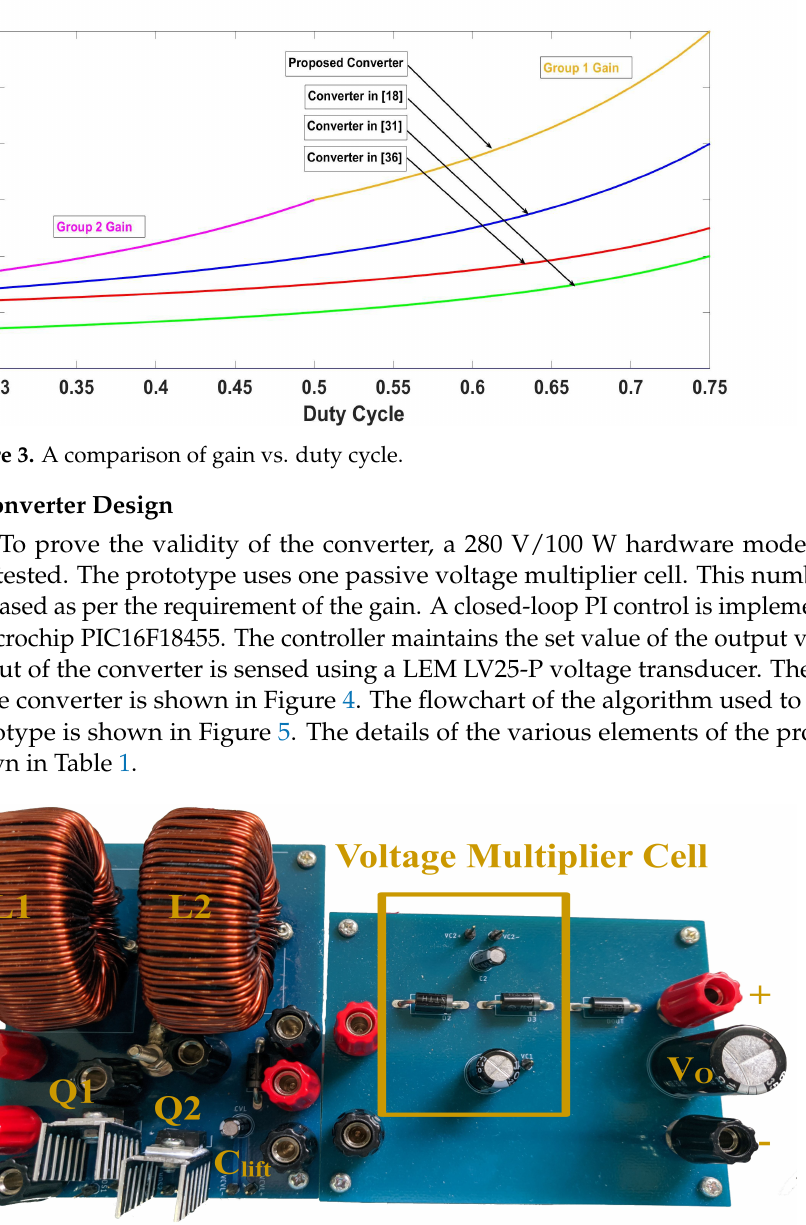
Figure 4. Hardware prototype of the proposed